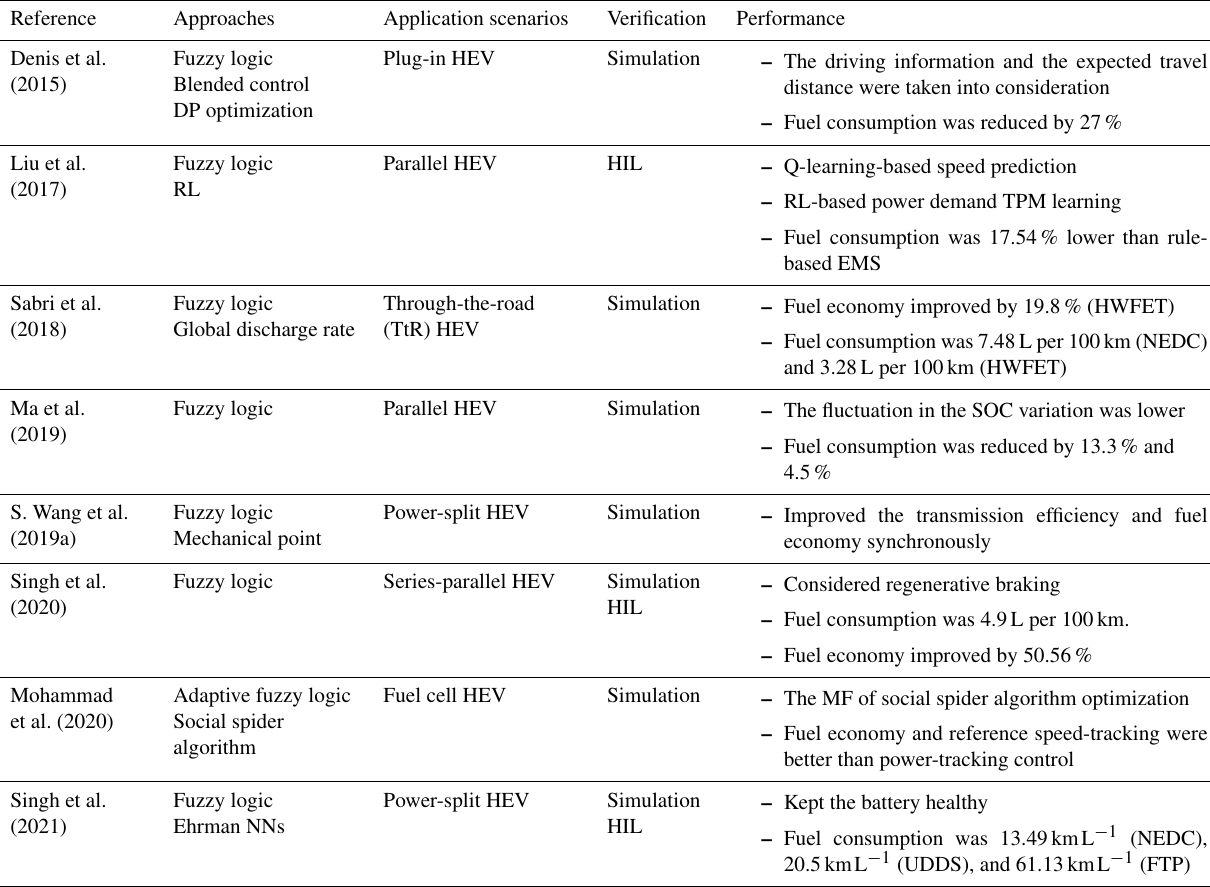
Table 3. Summary of exemplary works on fuzzy logic rule-based